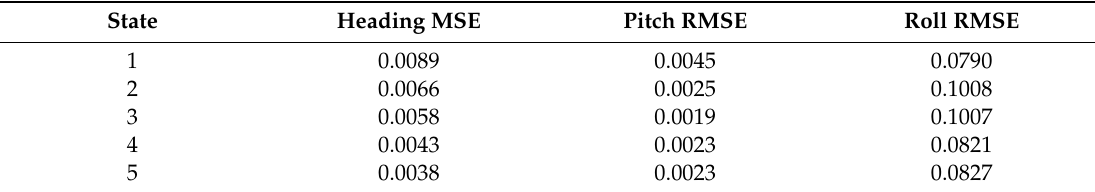
Table 4. Transfer alignment between main POS and MEMS ( ◦ ).